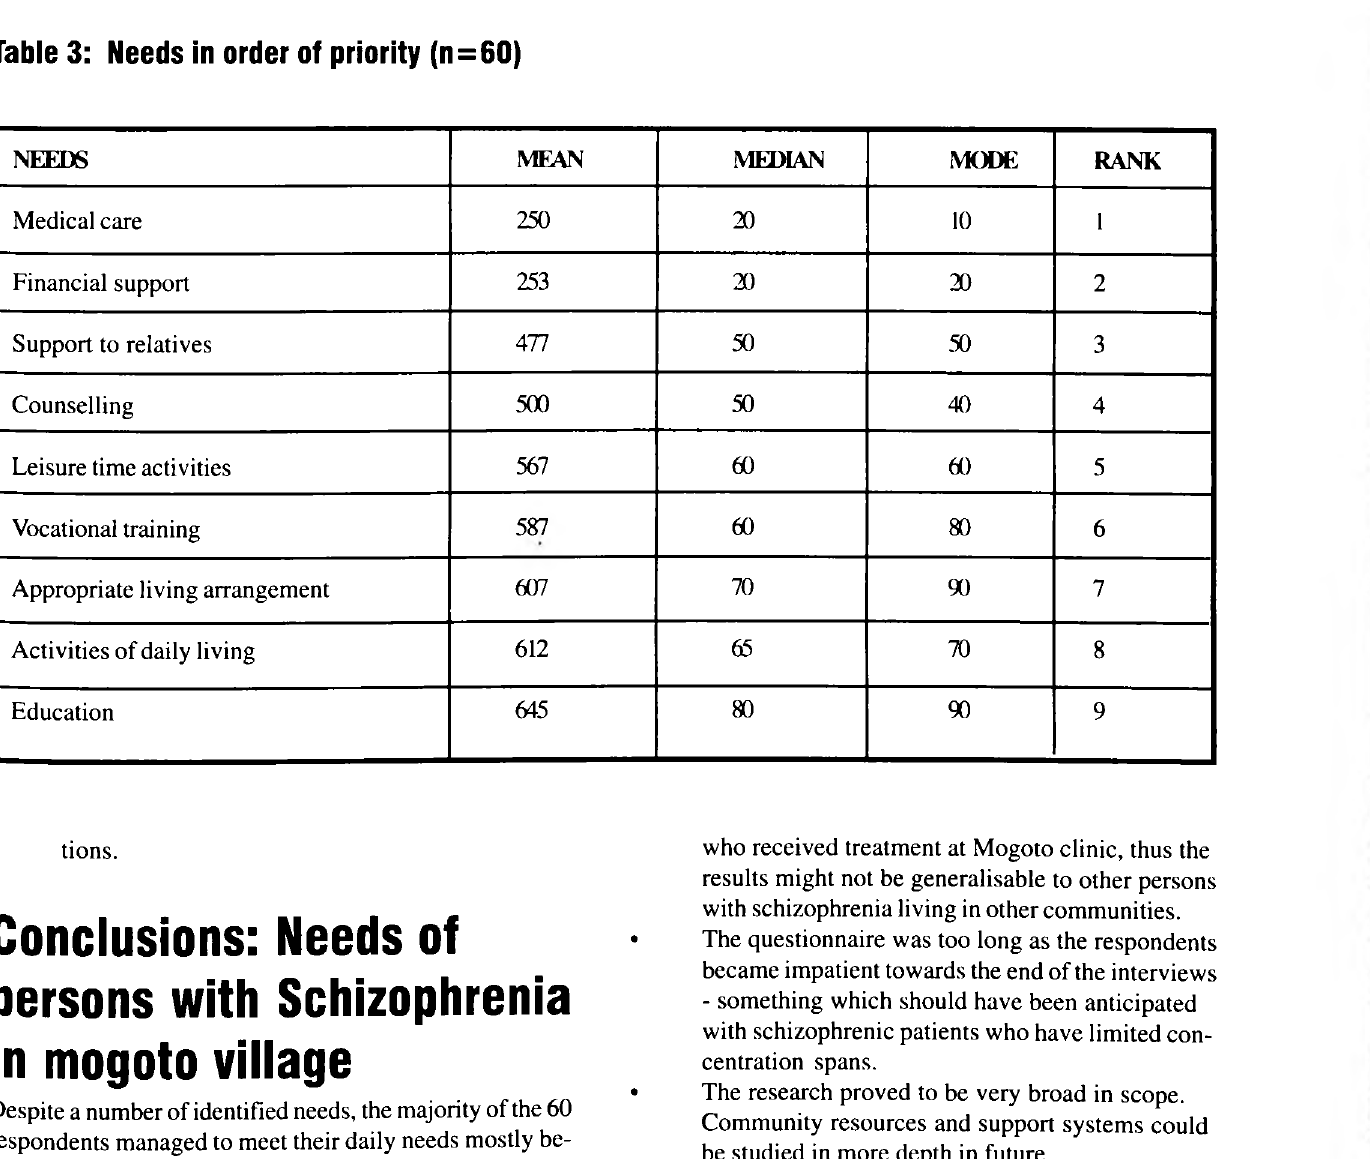
Table 3: Needs in order of priority